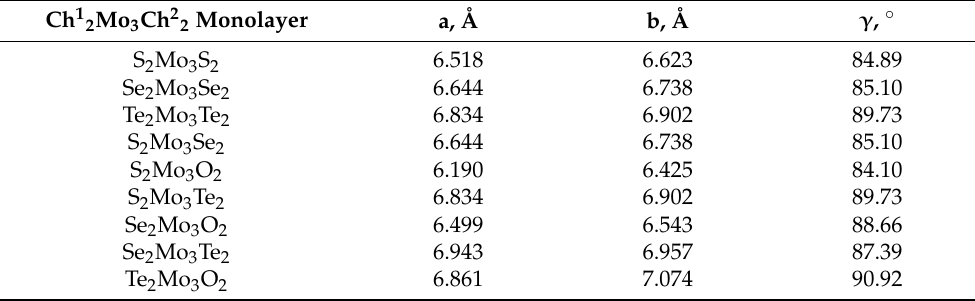
Figure 1. Atomic structure of a monolayer X 4 Mo 6 Y 4 Chevrel phase (X/Y = O, S, Se, Te or X = O, S, Se, Te; Y = F. Cl, Br, I) and a single X 4 Mo 6 X 4 cluster. The unit cell is highlighted by a black dashed line. Mo 6 octahedra and X 4 Y 4 cubes are marked by purple and blue lines, respectively. Table 1. Unit cell parameters for Ch 2 Mo 3 Ch 2 (Ch = S, Se, Te) Chevrel monolayers.